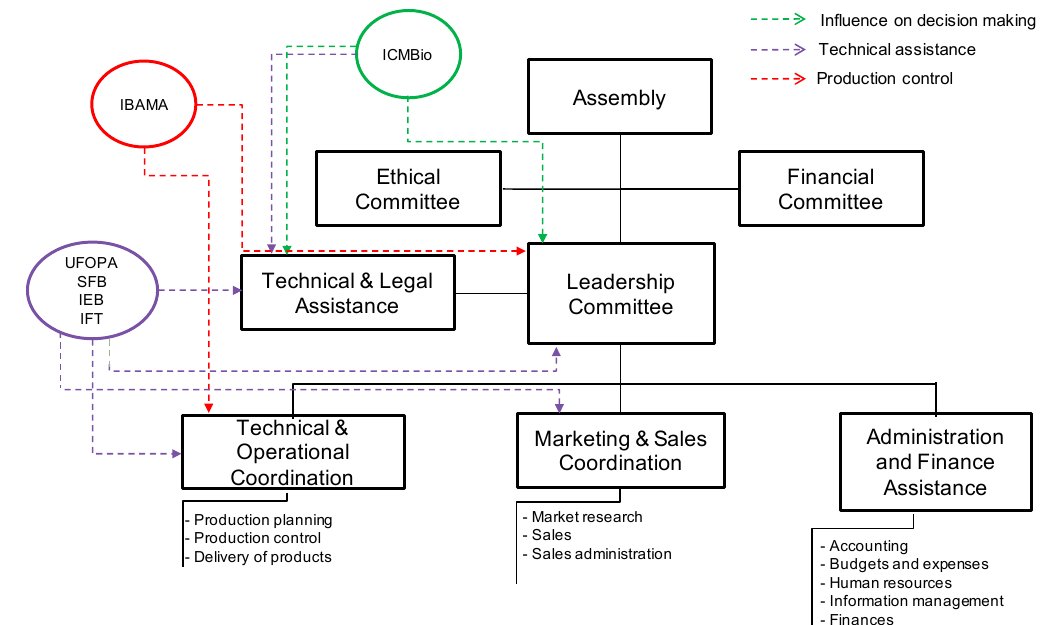
Figure 5. Influence relations in decision making, technical and institutional assistance, and timber production control according to the organization chart of the Mixed Cooperative of the Tapajós National Forest (Adapted from [98,107]).